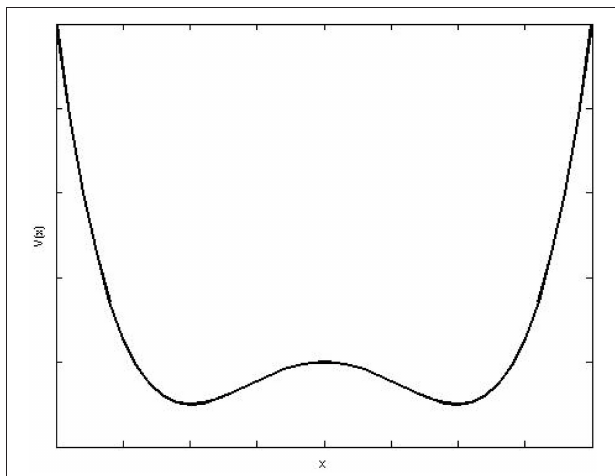
FIGURE 1 | SR in a double